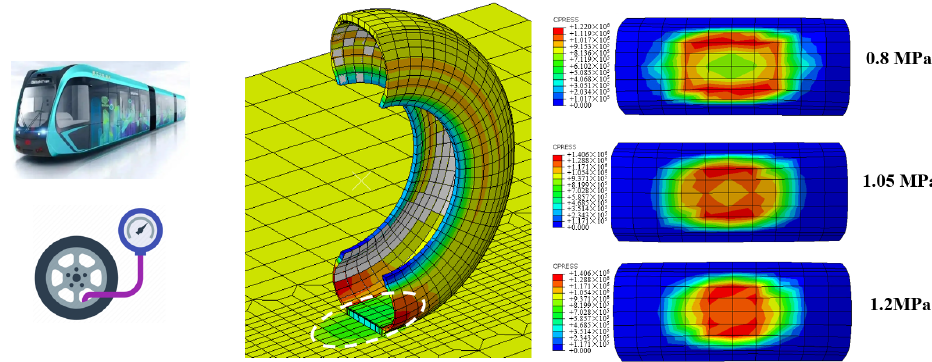
Figure 15. Tire–pavement contact press under different tire pressure.